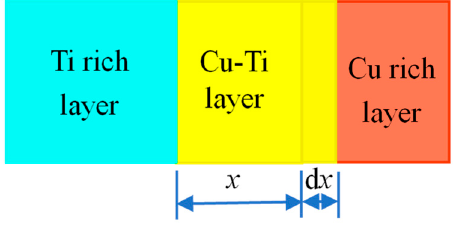
Figure 2. Schematic diagram of Cu-Ti reaction–diffusion layer without considering the Ti rich lay-